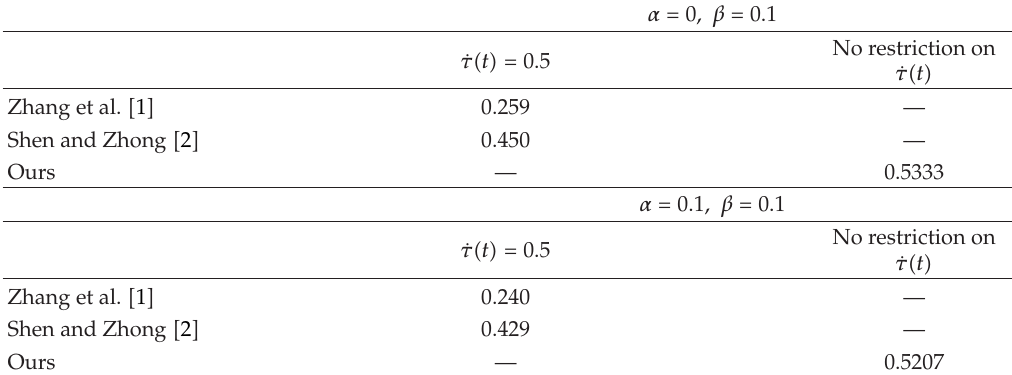
Table 2: Comparison of the maximum value τ M for γ (cid:9) 0 .